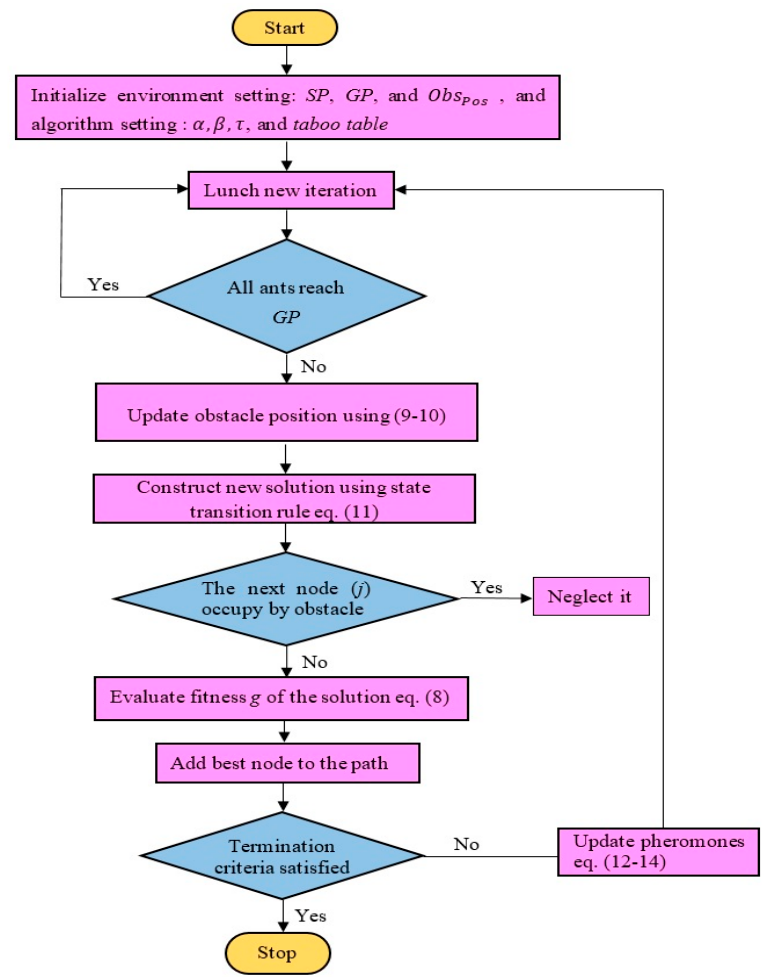
Figure 8. Flowchart of mobile robot path planning in a dynamic environment using AACO.